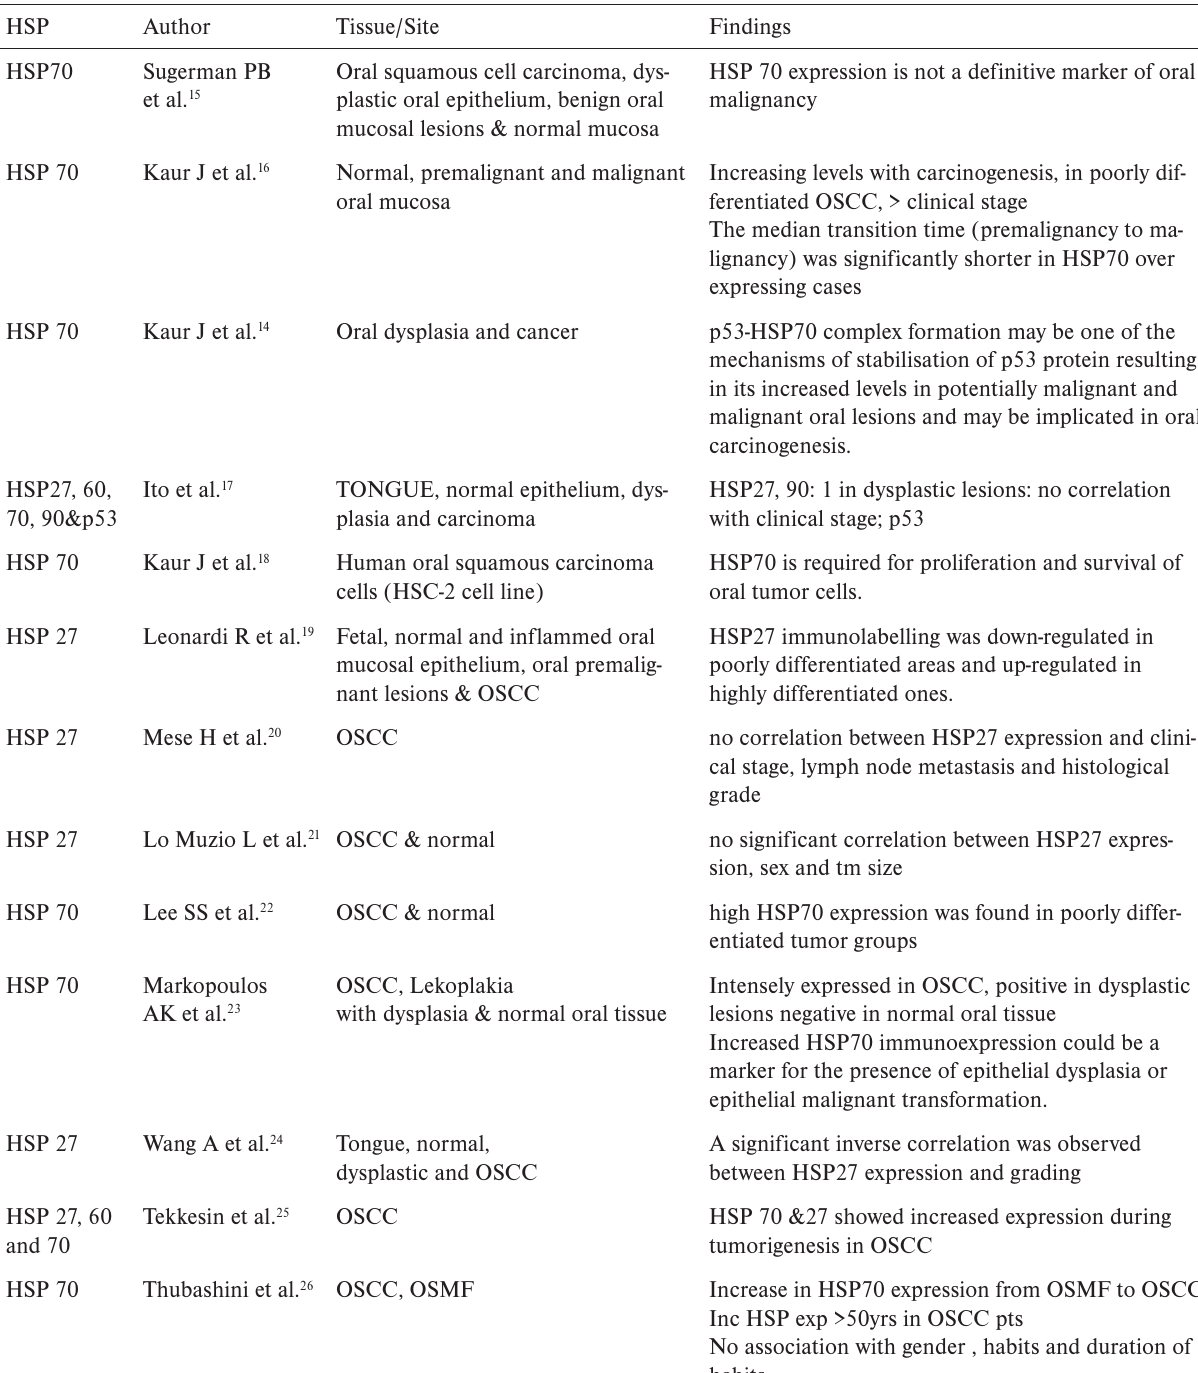
Table 1. Implications in diagnosis of oral